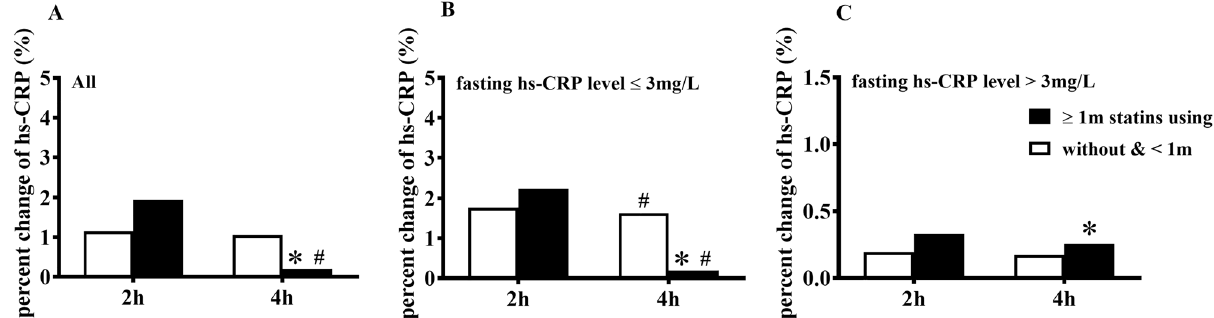
Figure 4. Comparisons of the percent changes of hs-CRP level between CHD patients with different terms of statins using. ( A ) Comparisons of the percent change of hs-CRP level at 2 h and 4 h after a daily meal between patients with different terms of statins using in all subjects (i.e., ≥ 1 m statins using, n = 130 vs. without and < 1 m statins using, n = 170). The percent change of hs-CRP level at 2 h was calculated by the formula: 100% × (hs-CRP 2h -hs-CRP 0h )/hs-CRP 0h , the percent change of hs-CRP level at 4 h was calculated by the formula: 100% × (hs-CRP 4h -hs-CRP 2h )/hs-CRP 2h . ( B ) Comparisons of the percent change of hs-CRP level at 2 h and 4 h after a daily meal between patients with different terms of statins using among those with fasting hs-CRP level ≤ 3 mg/L (i.e., ≥ 1 m statins using, n = 109 vs. without and < 1 m statins using, n = 103). ( C ) Comparisons of the percent change of hs-CRP level at 2 h and 4 h after a daily meal between patients with different terms of statins using among those with fasting hs-CRP level > 3 mg/L (i.e., ≥ 1 m statins using, n = 21 vs. without and < 1 m statins using, n = 67). * P < 0.05 when compared with those without and < 1 m statins using at the same time point. # P < 0.05 when compared with the percent change of hs-CRP at 2 h after daily meal within each